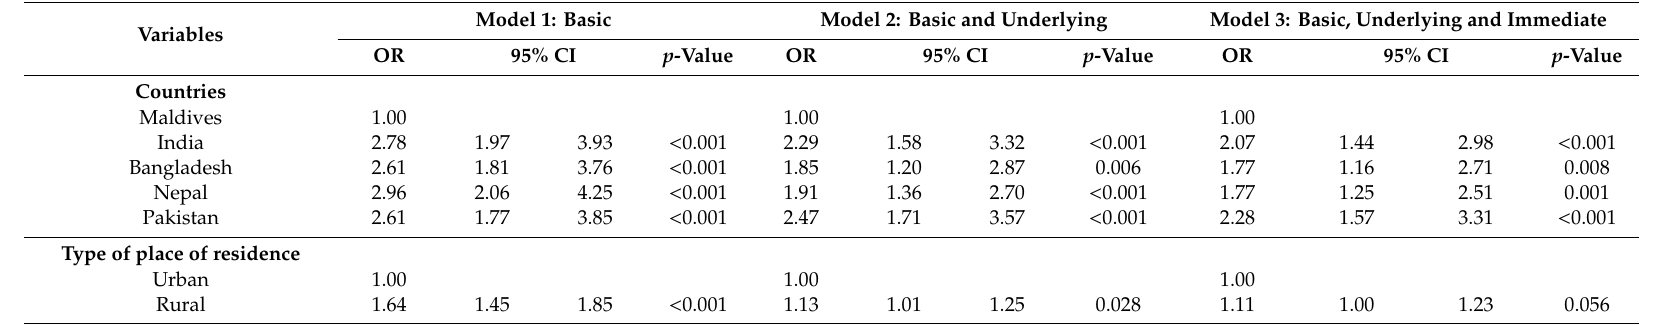
Table 3. Factors associated with stunting in children aged 0–59